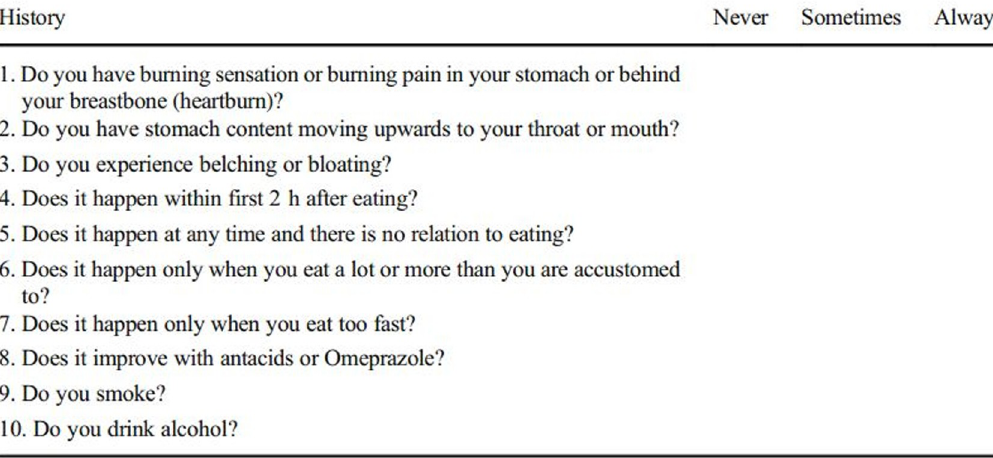
Fig 2. Standardized questionnaire for GERD in bariatric